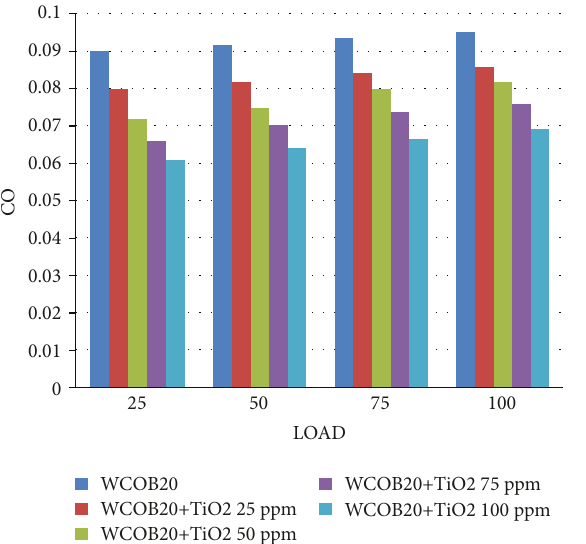
Figure 9: Carbon monoxide with respect to load.